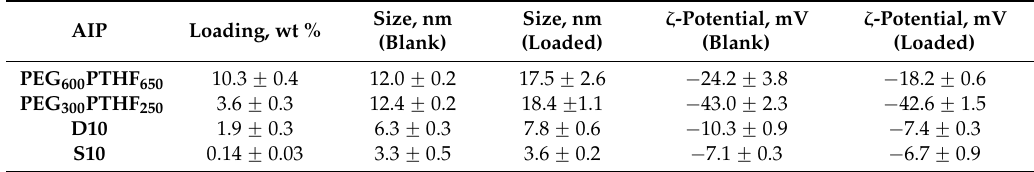
Table 1. Physical properties of blank and curcumin-loaded micellar assemblies at 1% concentration. Loading, AIP